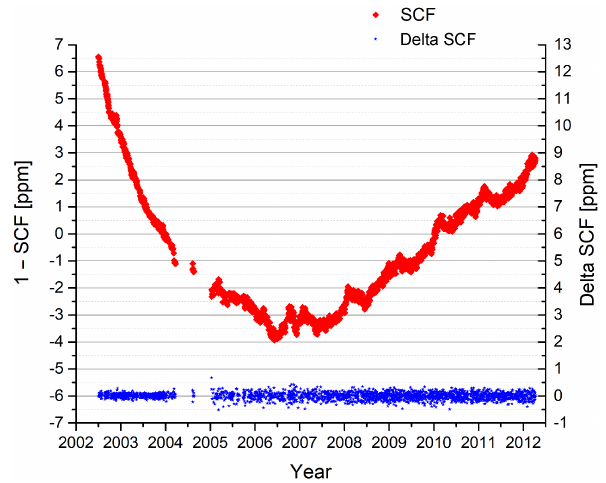
Figure 16. Spectral calibration factor (SCF) as determined from at- mospheric measurements over the mission (red). The difference be- tween subsequent SCF values is depicted in blue on the right axis.